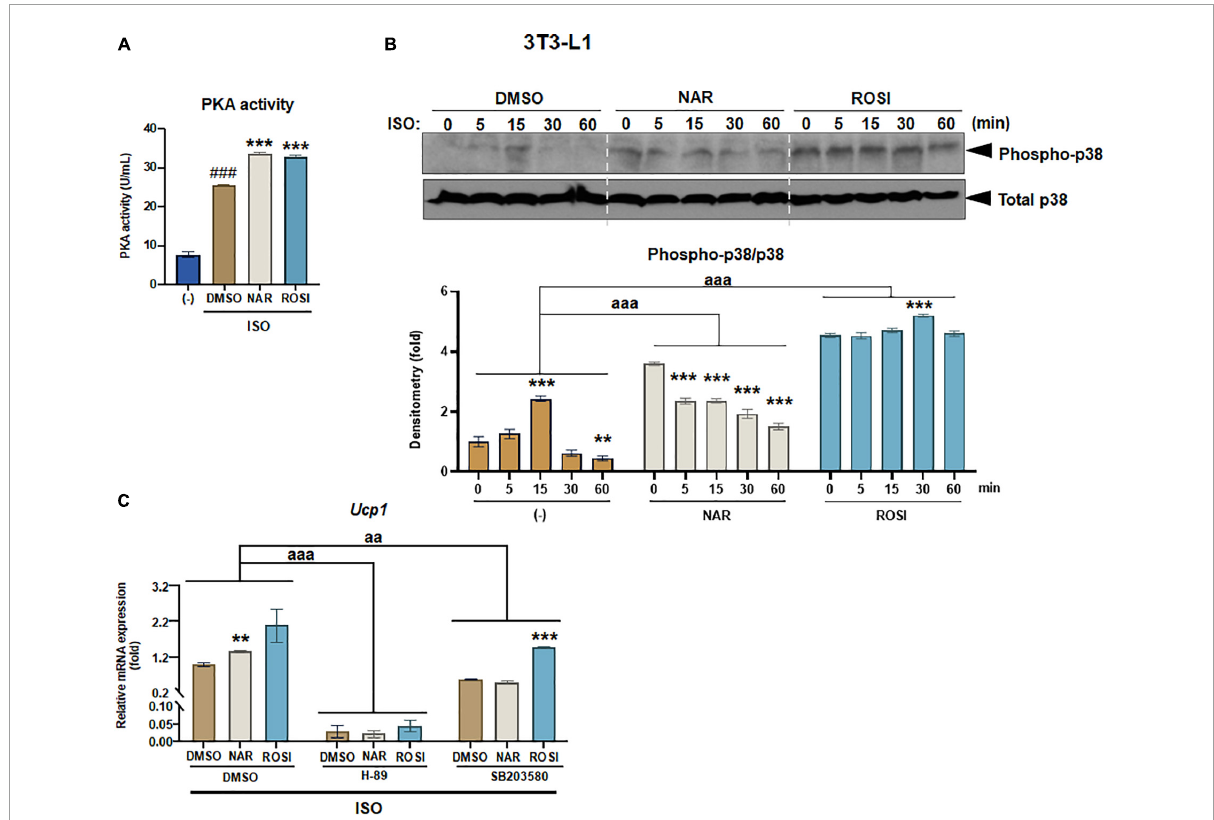
FIGURE3 Naringenin enhances protein kinase A (PKA) activation and phosphorylation of p38 MAPK required for Ucp1 up-regulation in isoproterenol (ISO)-stimulated 3T3-L1 adipocytes. 3T3-L1 cells were differentiated in the presence or absence of NAR (10 µ M) or ROSI (1 µ M) for 7 days. On day 7, the cells were stimulated with ISO (1 µ M) or the vehicle control for 6 h for PKA activity analysis (A) or 1 h for analysis of phosphorylation of p38 (B). In a separate experiment, the cells were pretreated with the pharmacological inhibitors of PKA (H-89) and p38 (SB203580) or the vehicle control (DMSO) for 1 h before ISO stimulation for 6 h for mRNA expression analysis (C). (A) PKA activity. (B) p38 phosphorylation analysis. (C) Effects of PKA and p38 inhibitors on ISO-stimulated Ucp1 up-regulation by NAR. Ucp1 mRNA expression is presented relatively to the loading control 36b4. Data = Mean ± SEM ( n = 3). ### p < 0.001 compared to the non-ISO stimulated (–) samples (A) . *, **, *** p < 0.05, p < 0.01, and p < 0.001 compared to the ISO-stimulated time 0 (B) or DMSO samples (C) within each group, respectively. aa and aaa, p <